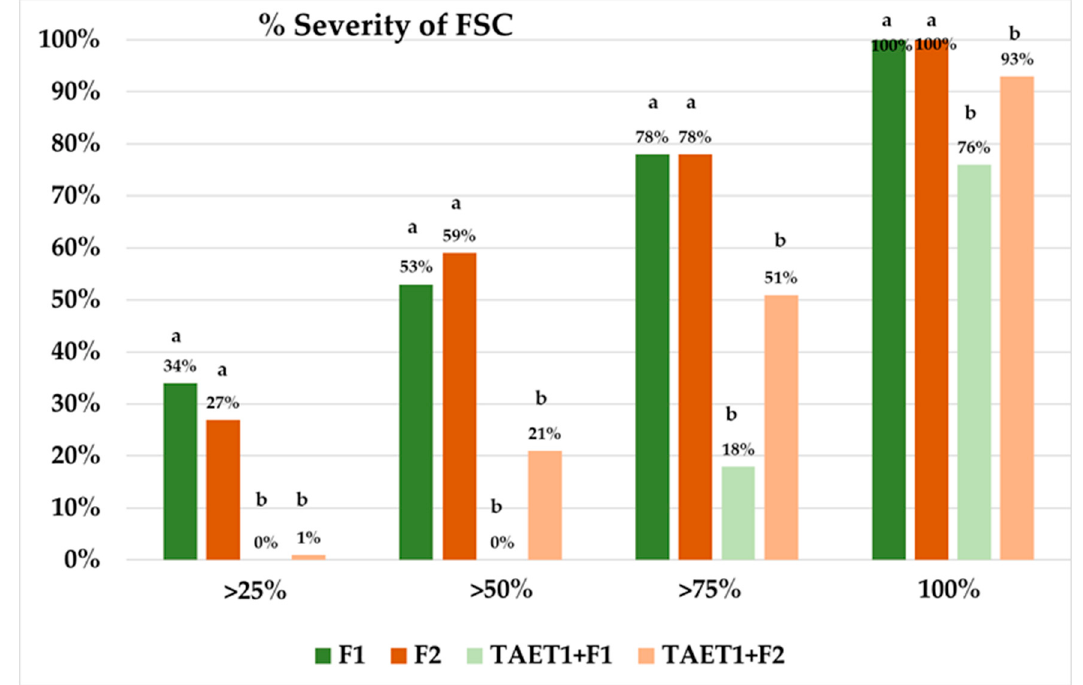
Figure 8. Comparison of the TAET1 effect on the percentage of disease severity after applying two doses of FSC (F1: 10 5 CFU mL − 1 ; F2: 10 4 CFU mL − 1 . 25, 50, 75, and 100%: disease severity percentages higher than 25%, 50%, 75%, and 100% for F1 and F2. Means with the same letter are not significantly different (LSD) according to the ANOVA ( p < 0.05). In turn, foliar application of TAET1 considerably suppressed the disease caused by P. xanthii (Figure 9), with a reduction of 66.78% in the proportion of leaf area showing symptoms. Similarly, the number of leaves and petioles with powdery mildew was reduced by 31.42% and 33.39%,